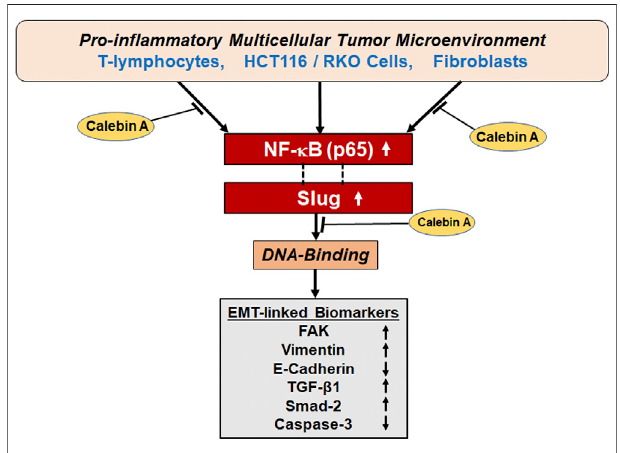
FIGURE 9 | A graphic presentation of the antitumorigenic actions of Calebin A via modulation of EMT and Slug/NF- κ B axis of colorectal cancer cells in pro-in fl ammatory multicellular